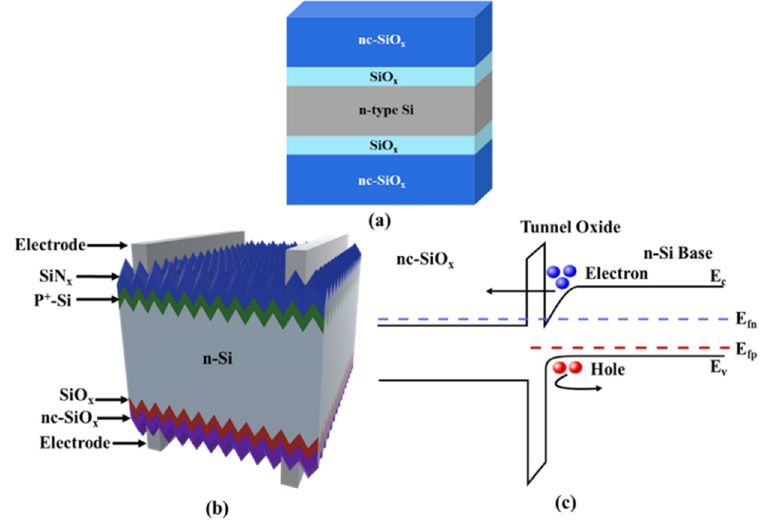
Figure 1. ( a ) Symmetric structure for measuring passivation characteristics, ( b ) graphical depiction of the TOPCon solar cell and ( c ) the schematic band diagram of the tunnel oxide passivating contact structure.